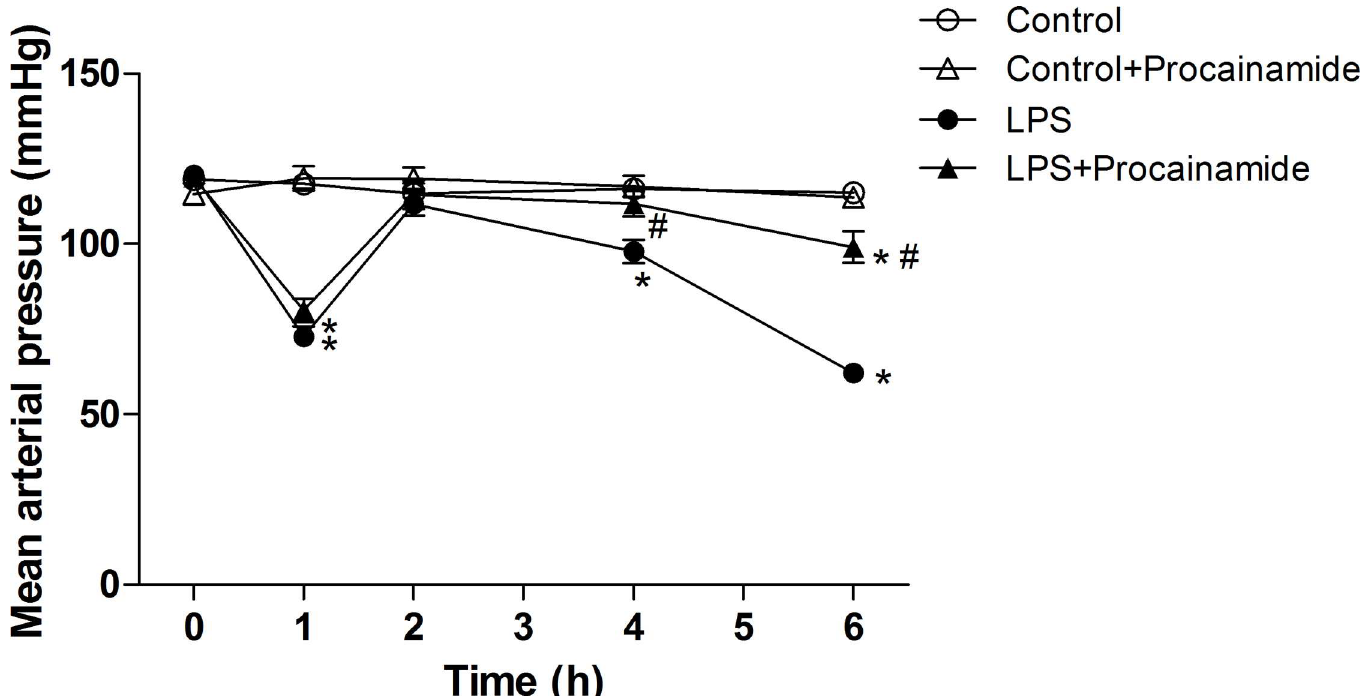
Fig 1. Effects of procainamide on mean arterial pressure in endotoxemic rats. Depicted are the changes during the experimental period in different groups of animals that received saline at time 0 (Control, n = 8), received saline as in Control group and then received procainamide at 1 h (Control + Procainamide, n = 8), received LPS at time 0 (LPS, n = 10), and received LPS at time 0 and then received procainamide at 1 h (LPS + Procainamide, n = 10). Data are expressed as mean ± SEM. * P < 0.05, all versus Control rats; # P < 0.05, with versus without procainamide in LPS rats